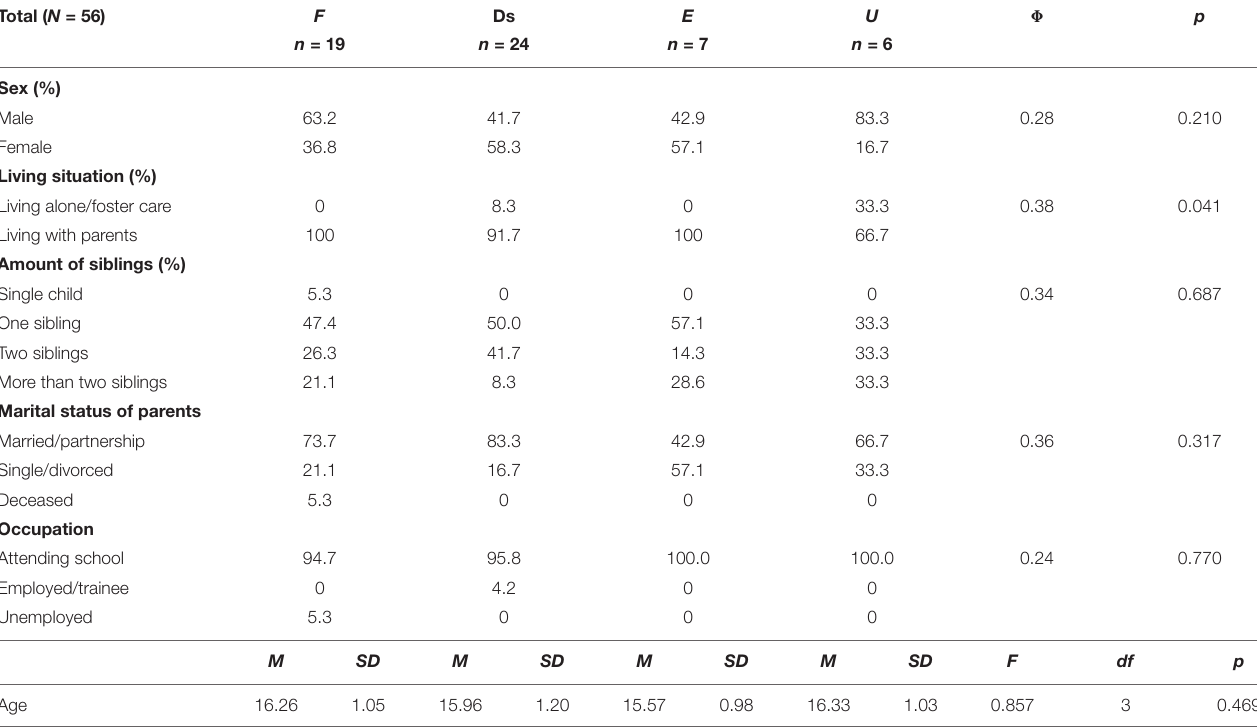
TABLE 1 | Sociodemographic characteristics among the four attachment